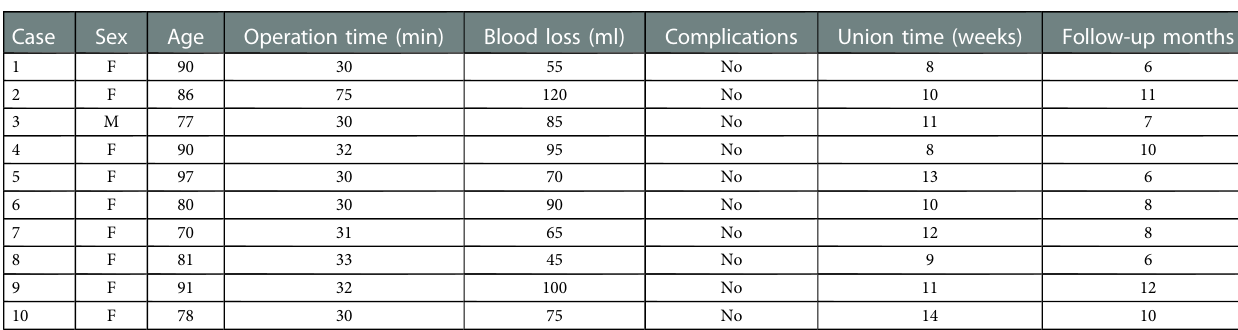
TABLE 1 Patients demographics and